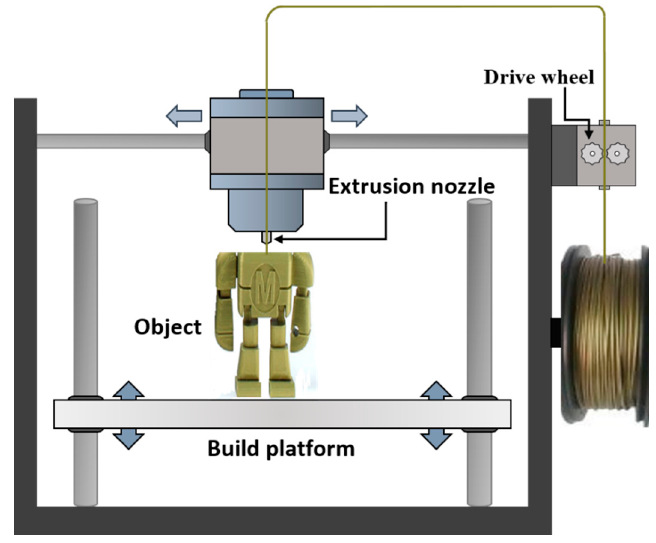
Figure 1. Schematic of FFF process for the printing of parts using the melted polymer filament.